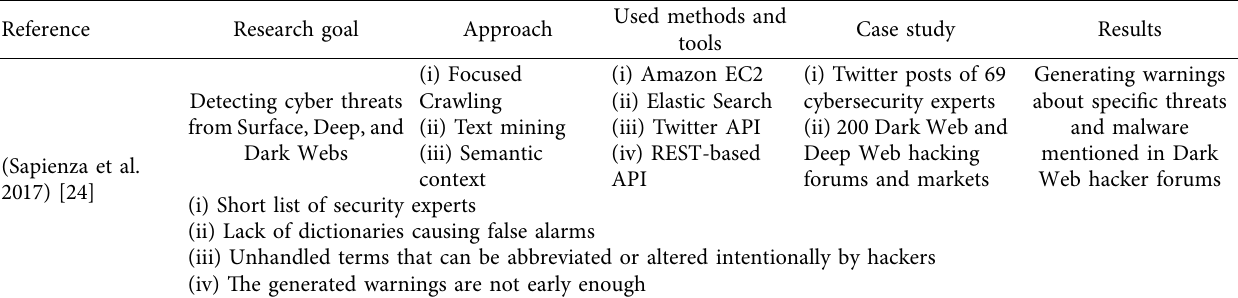
Table 1: A comparison of reviewed literature according to their goal, approaches, used methods and tools, case studies, results, and possible